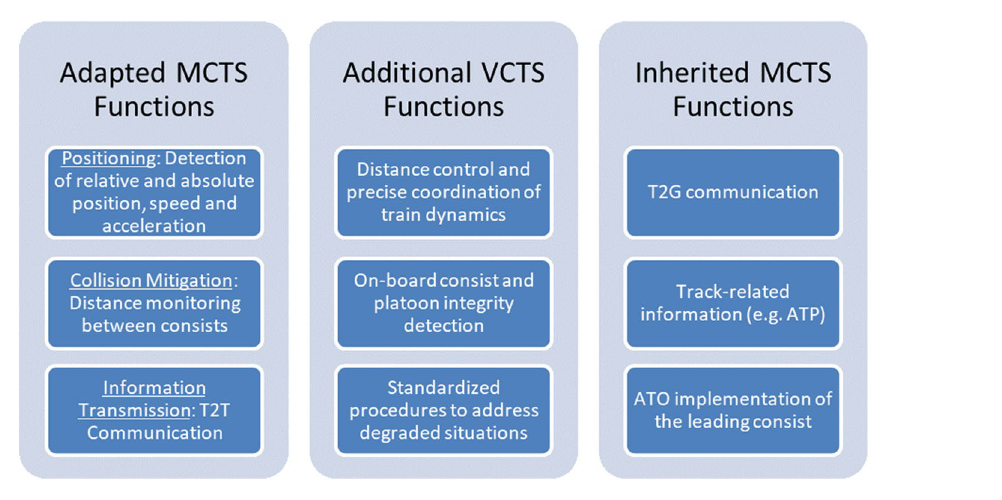
Figure 6. Functions to be provided by VCTS in stage